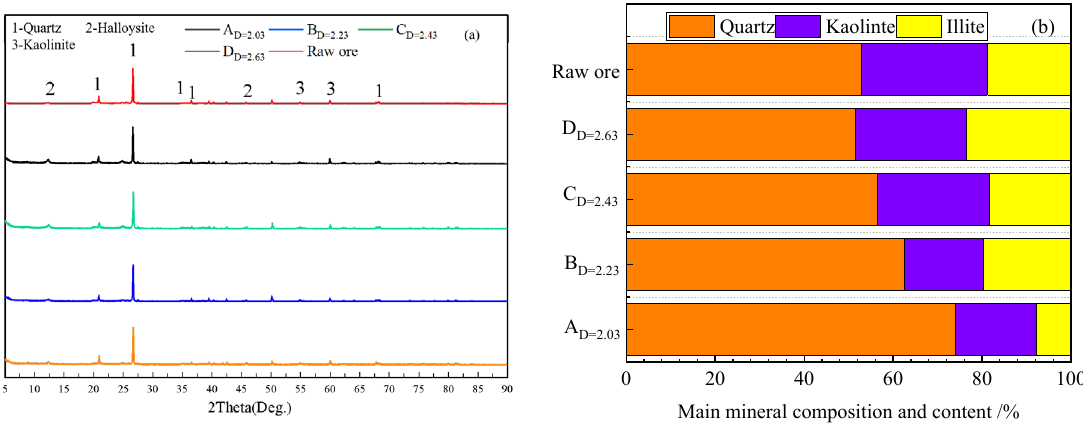
Figure 2. Main mineral composition and content of ore samples. ( a ) XRD profiles of ore samples ; ( b ) Mineral content .